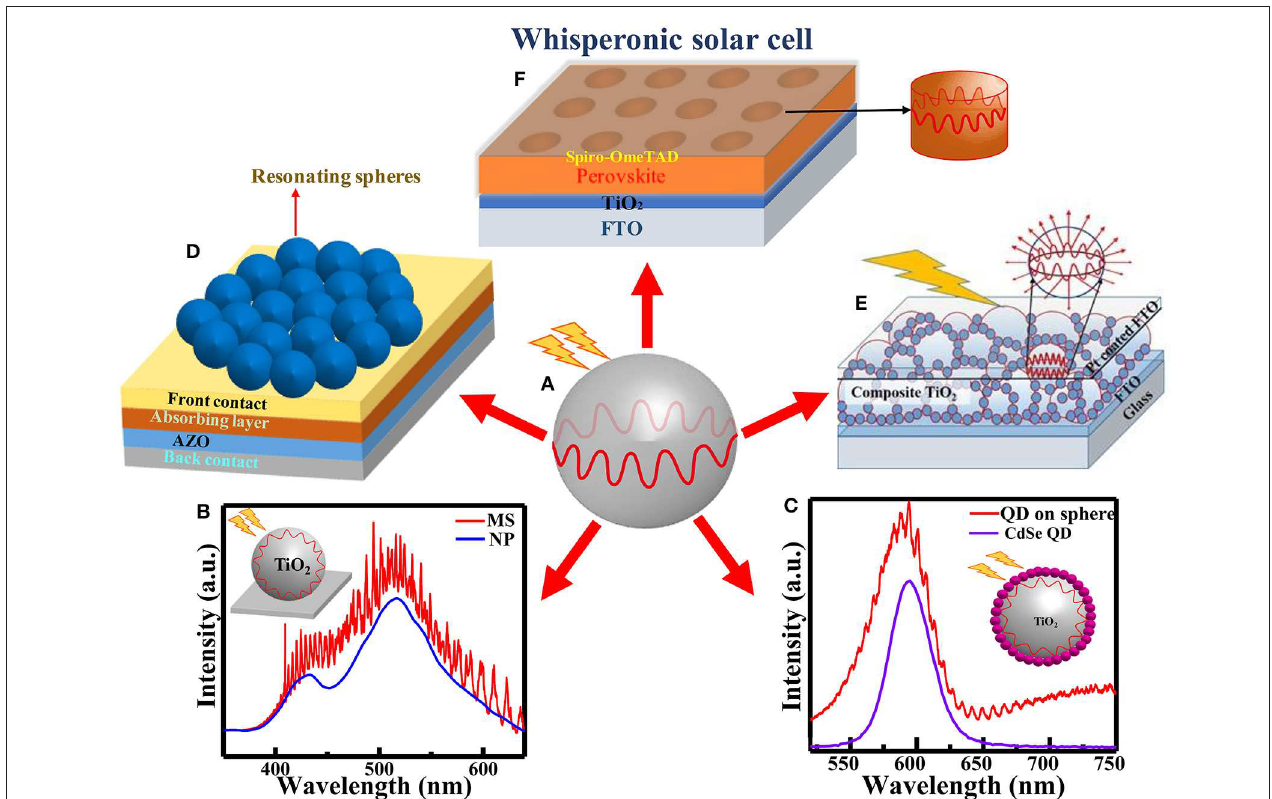
FIGURE 1 | (A) Schematic of WGM in a spherical microcavity. (B) PL spectra of isolated TiO 2 microsphere and its nanoparticle counterpart (adapted from Das et al., 2018a , with permission from American Chemical Society). (C) PL spectra of bare CdSe QD and QD loaded on TiO 2 microsphere (adapted from Das et al., 2018a, with permission from American Chemical Society). Application of WGM resonators in different solar cell architectures: (D) a -Si solar cell with close packed dielectric resonant nanospheres (adapted from Grandidier et al., 2011, with permission from John Wiley and Sons). (E) Schematic of whisperonic QDSSC (adapted from Das et al., 2018b , with permission from Springer Nature). (F) Schematic of whispering gallery perovskite solar cell (adapted from Wang et al., 2018a, Copyright